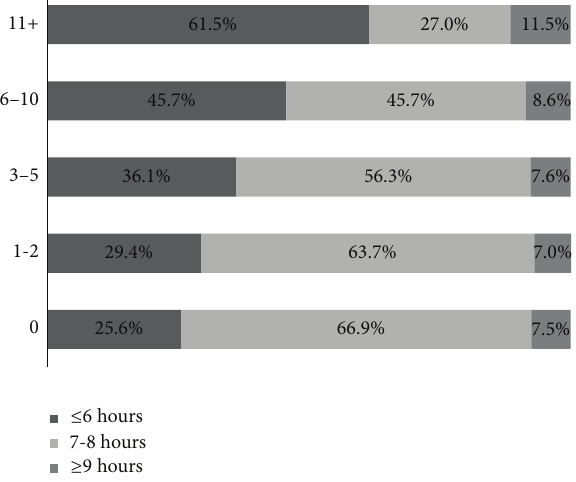
Figure 2: Distribution of average hours sleep in 24-hour period by K6 category among adults aged ≥ 18 years in 5 states, Behavioral Risk Factor Surveillance System,